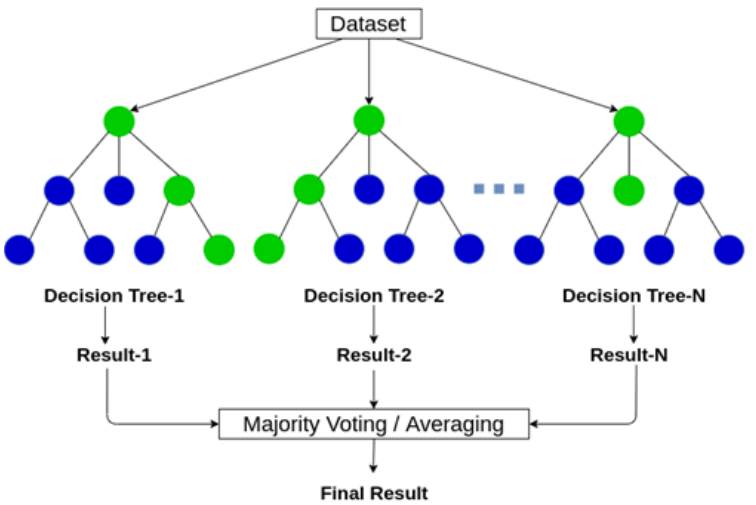
Figure 1. Diagrammatic representation of a random forest (for further details, see https:// www.analyticsvidhya.com/blog/2020/05/decision-tree-vs-random-forest-algorithm/ (accessed on 1 April